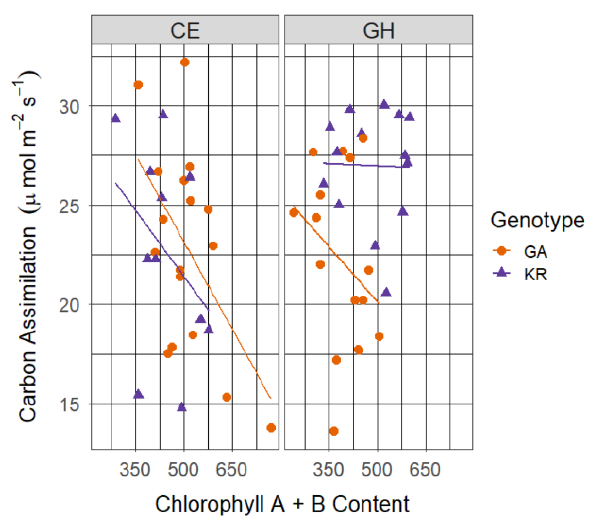
Figure 6. The impact of chlorophyll A + B content on CO 2 assimilation rate ( A ) for two wheat cultivars